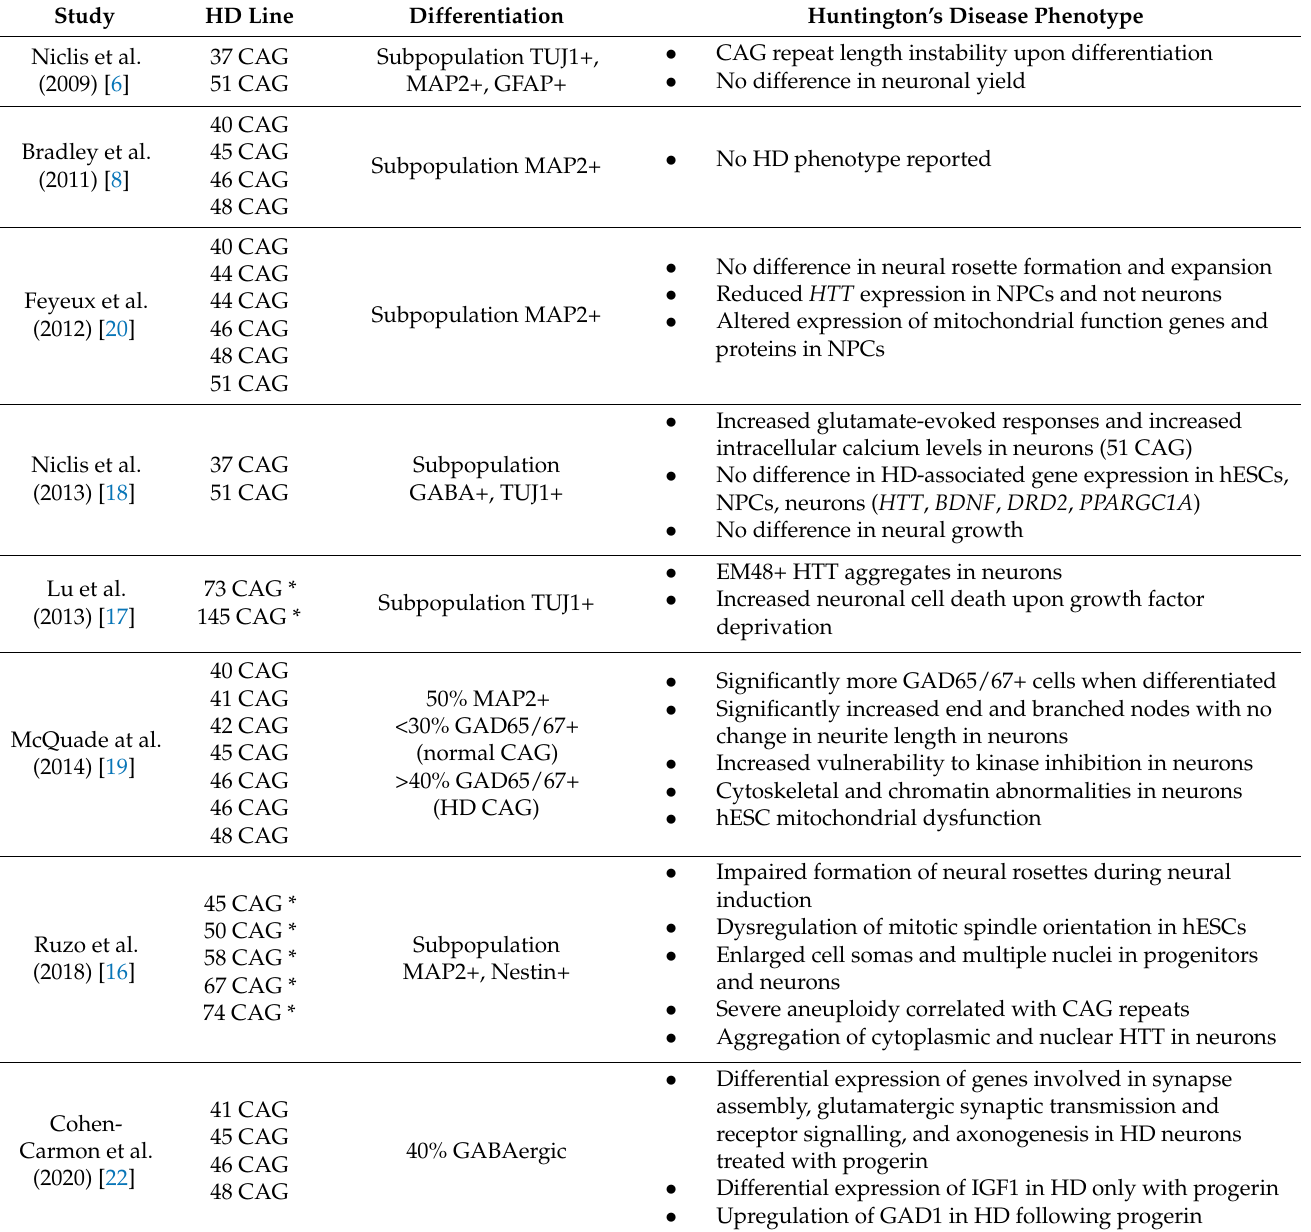
Table 1. Studies that have generated neurons from Huntington’s disease human embryonic stem cells.